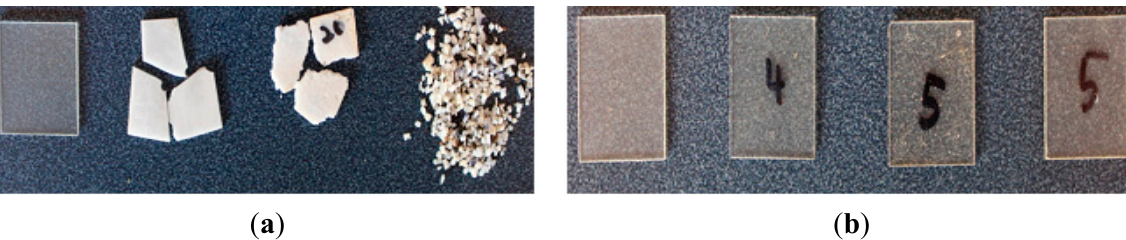
Figure 8. Photographs for the biodegradation of virgin PLA in controlled ( a ) and real composting conditions ( b ).